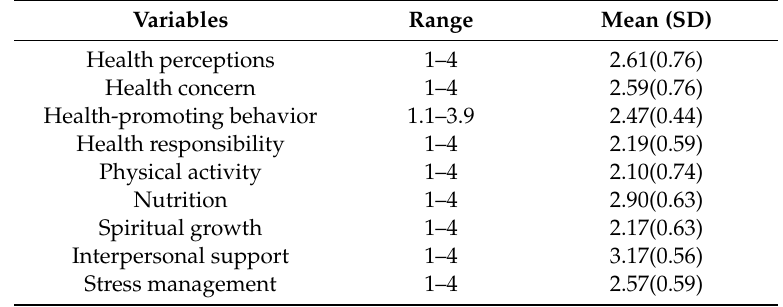
Table 3. Levels of health perceptions, health concern, and health-promoting behaviors (N =